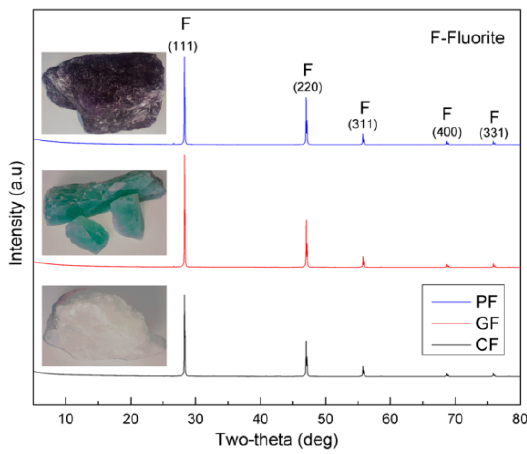
Figure 1. X-ray diffraction (XRD) patterns of colorless fluorite (CF), green fluorite (GF), and purple fluorite (PF).